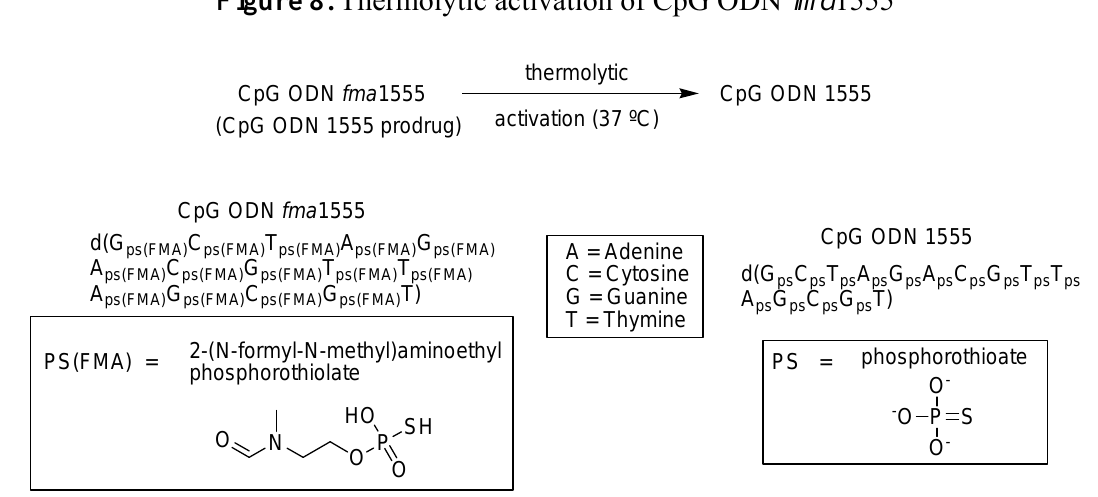
Figure 8. Thermolytic activation of CpG ODN fma